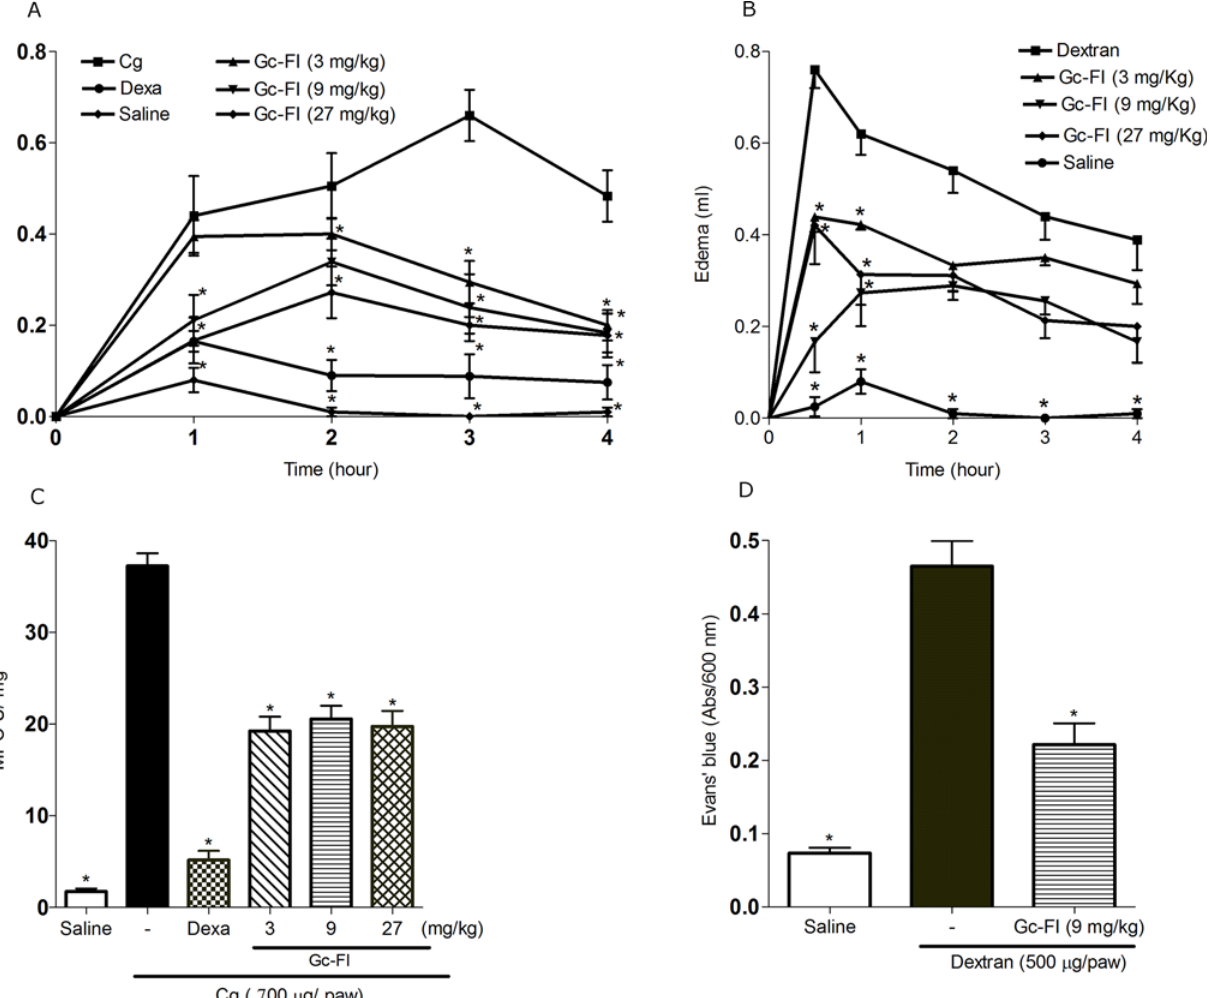
Fig 2. Effect of Gc-FI on paw edema induced by Cg (A) or dextran (B). MPO activity (C) and vascular permeability (D). Mean ± SEM (%, n = 6) (ANOVA, Bonferroni ’ s test). * p < 0.05 or p < 0.001 compared with the